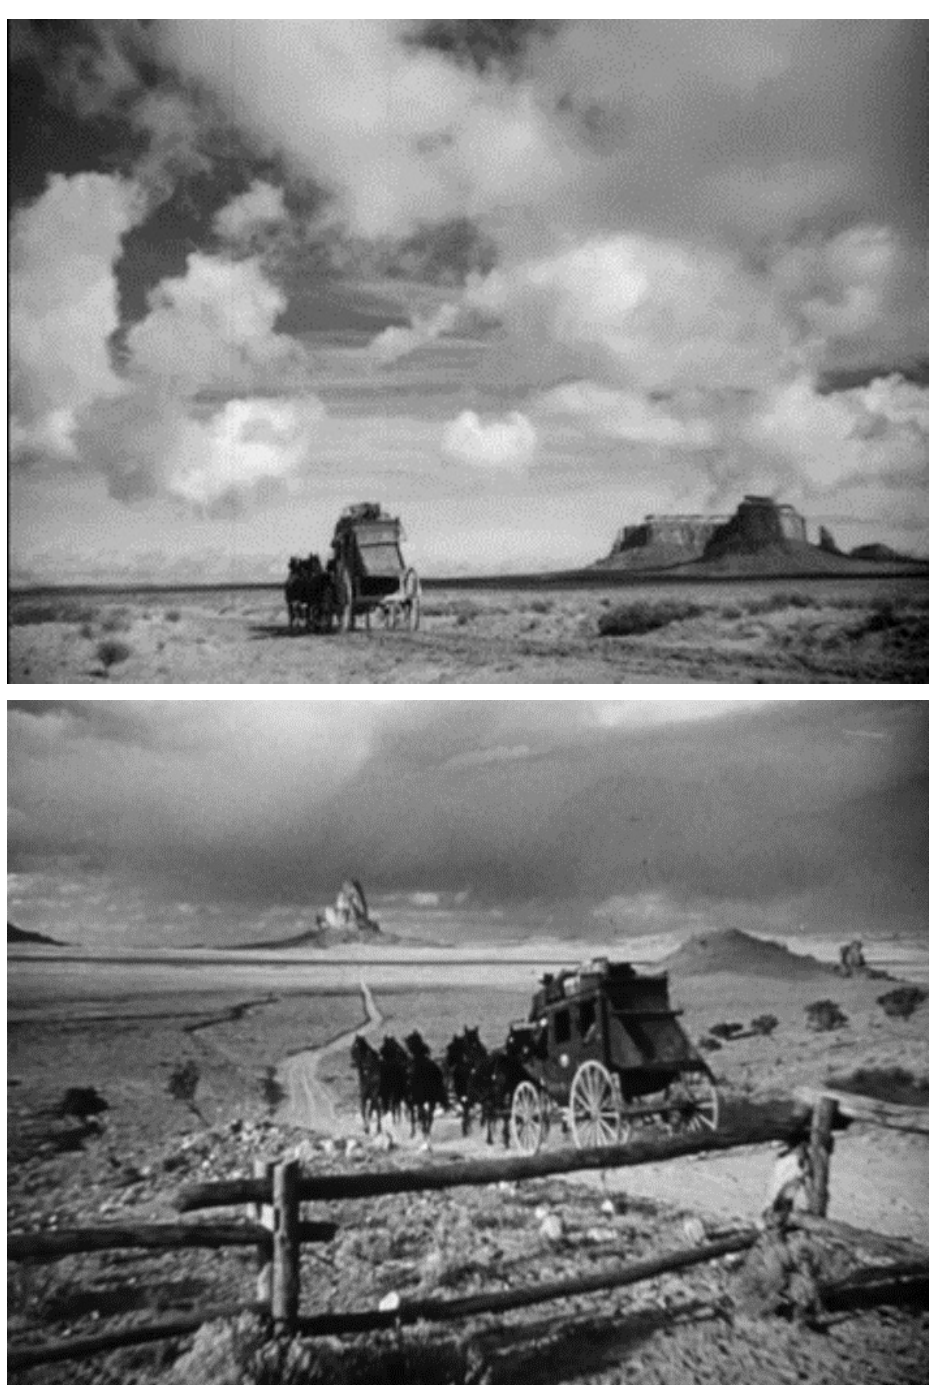
Figure 1: John Ford’s favourite film location in Monument Valley, Utah. The stage- coach, that representative vessel of civilisation, heads into the vast western wilderness. Shots such as these propelled the western into prominence fuelling the American ethos of re-creating oneself in the new, boundless and unwritten nation. Film as a medium captured this sensibility so well that it superseded all other media for the western